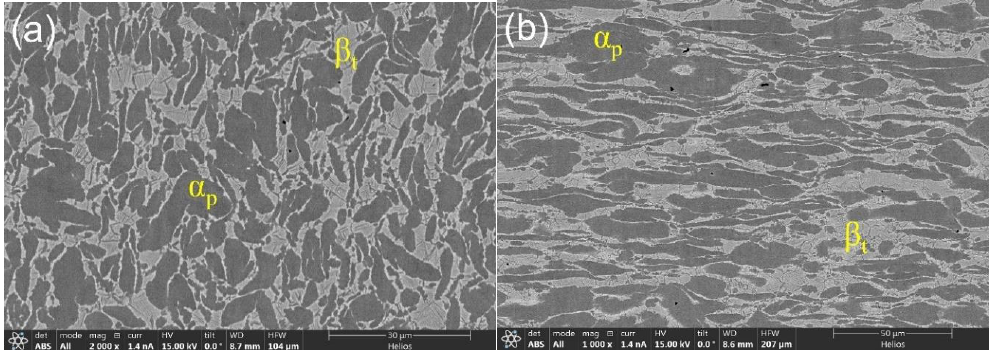
Figure 1. Microstructure images of the studied TC11 titanium alloy: ( a ) transverse section, and ( b ) longitudinal section.